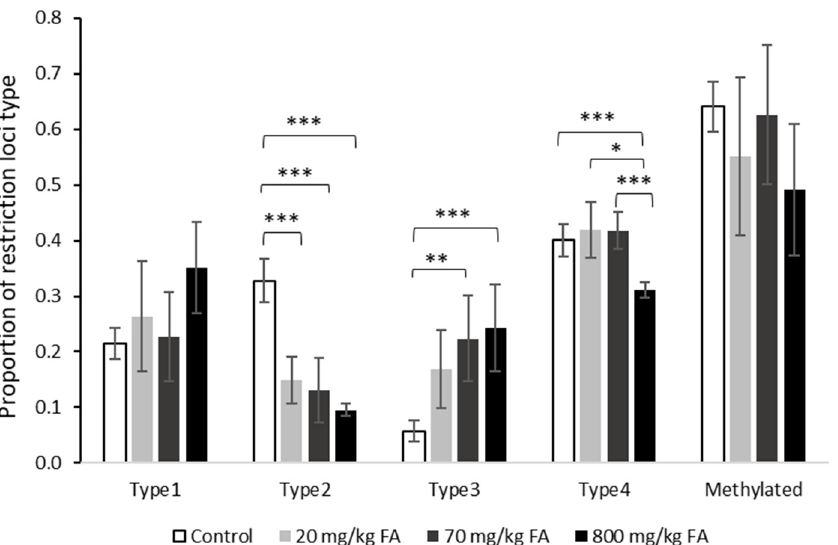
Figure 6. DNA methylation in methylation-sensitive loci detected from L. rubellus exposed for 308 days to a control 20.8, 70, and 800 mg/kg per dry weight soil fluoranthene; Types 1 to 4 are, respectively: Type 1. no methylation; Type 2. methylation of internal C; Type 3. methylation of external C or hemi-methylation; and Type 4. hypermethylation or mutation in restriction site (of the 5 ′ -CCGG-3 ′ sequence). Global methylation level estimated following Nicotra et al., as proportion of (Type 2 + Type 3 loci/Type 2+Type 3 + Type 1 (scorable loci). Asterisks indicate significant between scorable loci types at * p < 0.05, ** p < 0.01, *** p < 0.001.